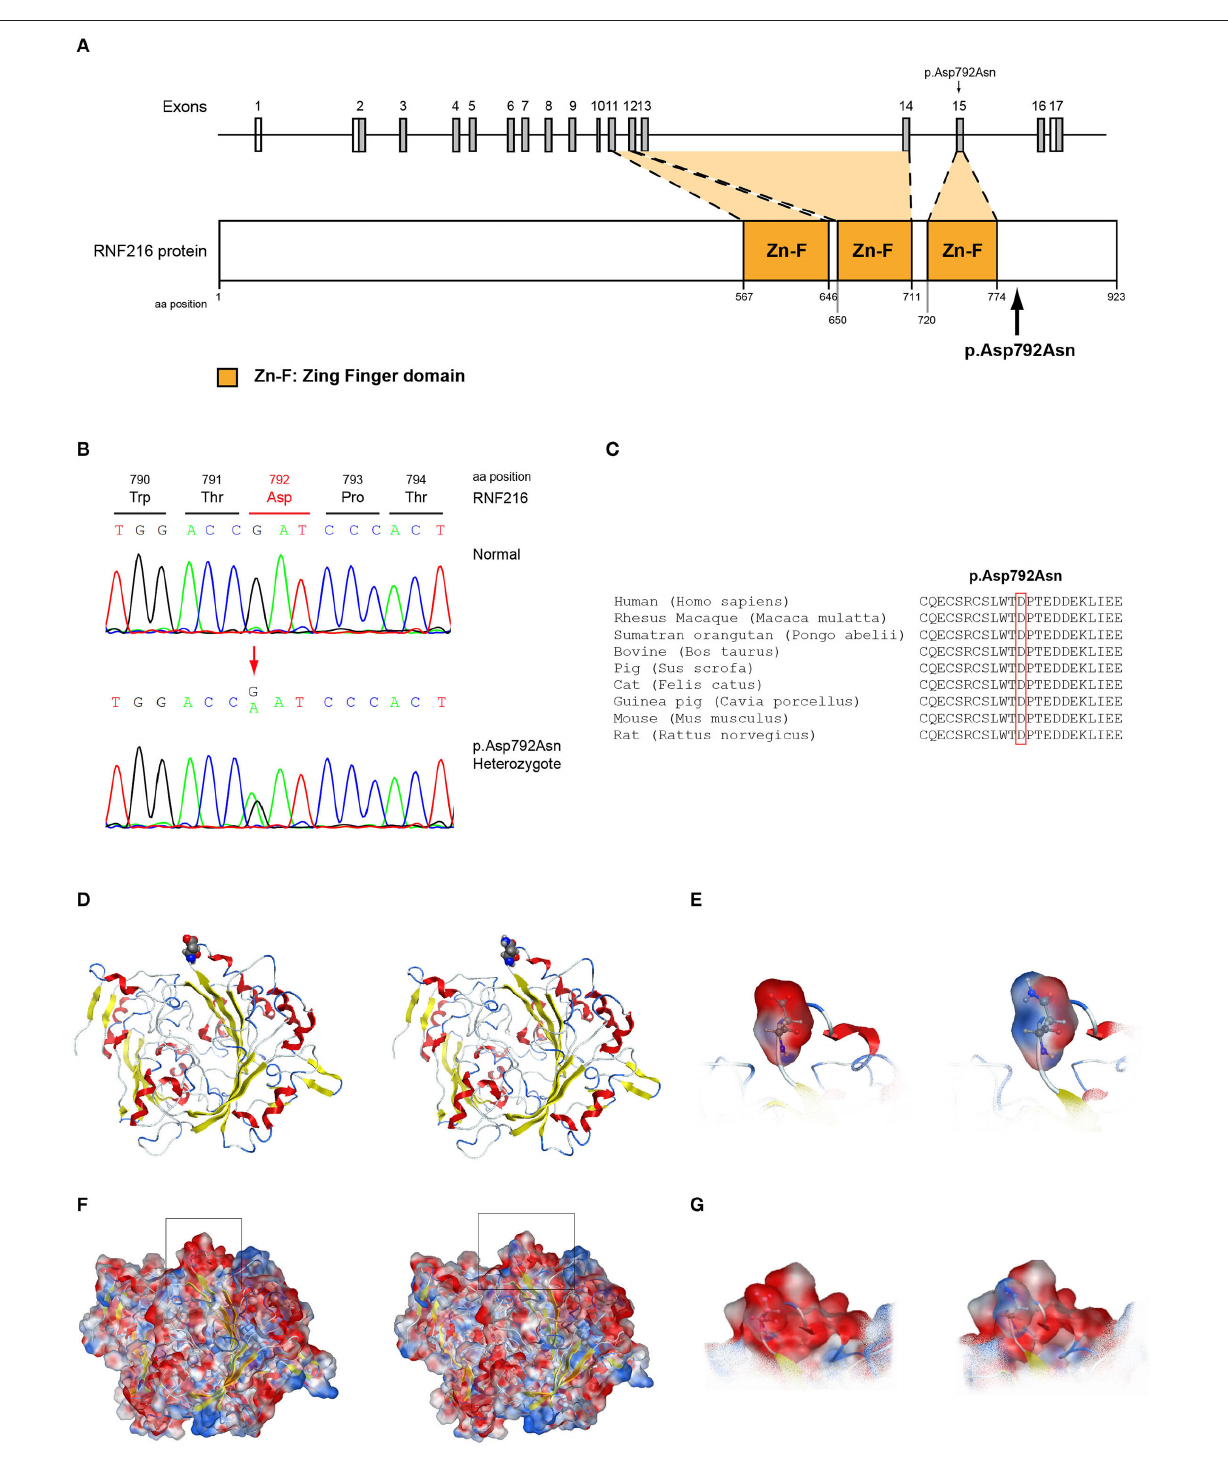
Frontiers in Endocrinology | www.frontiersin.org